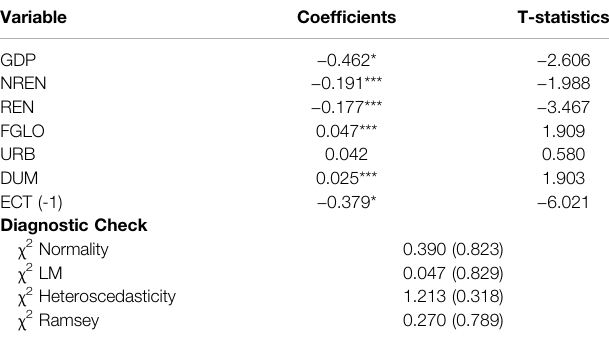
TABLE 5 | ARDL estimators outcome.